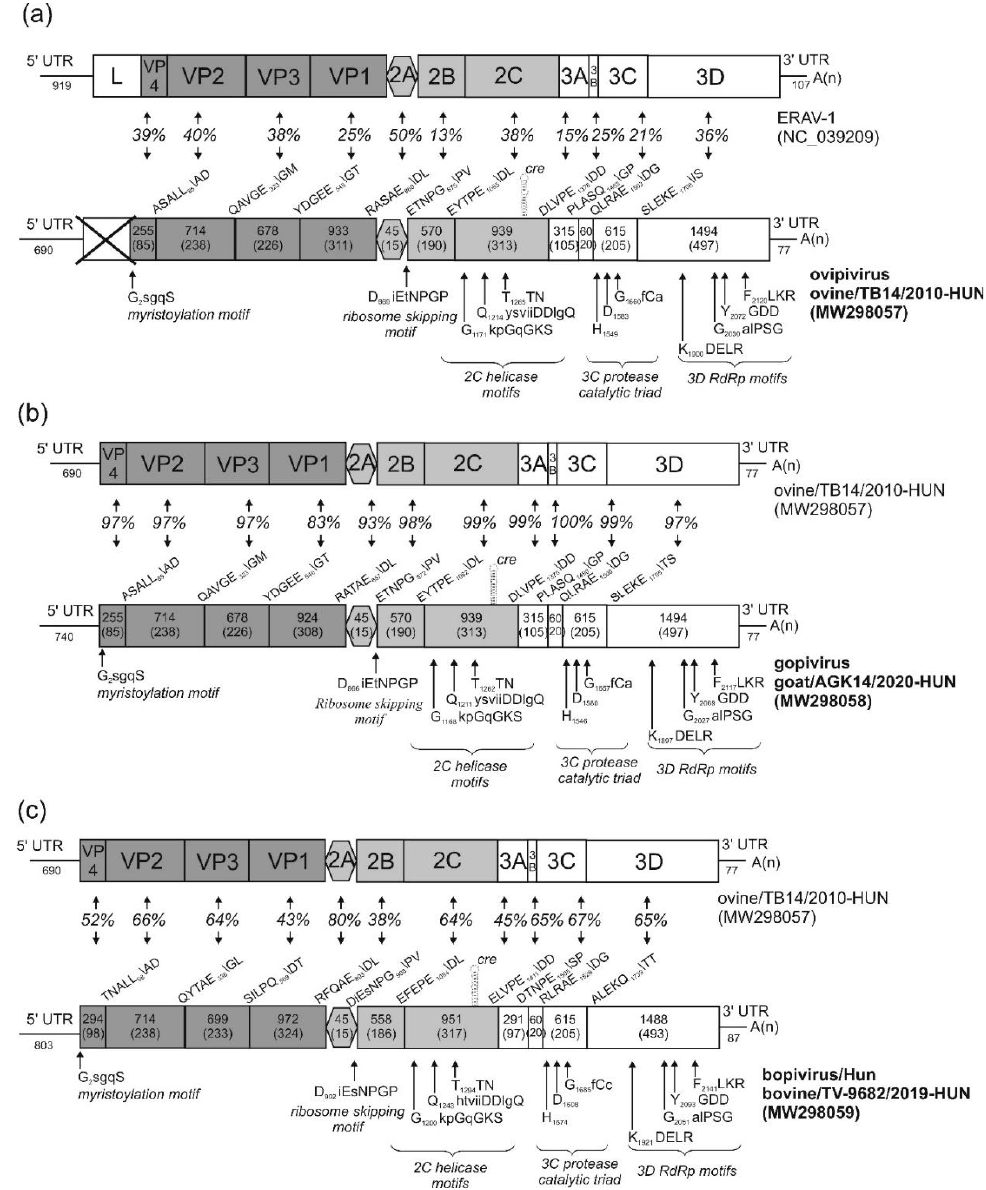
Figure 2. Schematic genome maps with conserved amino acid motifs and presumed cleavage sites (P5\P2 ′ ) of ovipivirus ( a ), gopivirus ( b ) and bopivirus/Hun ( c ) (bottom side of the panels) and their closest relatives (top side). The gene boxes corresponding to the P1 viral capsid proteins and P2 non-structural proteins are highlighted with different shades of grey. The nucleotide (upper numbers) and amino acid (lower numbers in brackets) lengths of the corresponding genomic regions of the study viruses are shown in each gene box. The positions and sequences of conserved amino acid motifs of 2C Helicase, 3C Protease and 3D RdRp (RNA-dependent RNA polymerase) are shown under each map of the study viruses. Conserved and variable amino acids are represented by uppercase and lowercase letters, respectively. The pairwise amino acid identity values (%) of each genomic region are found between the genome maps. cre : cis-acting replication element. The 5 (cid:48) UTR is 690 nt-long, 440 nt longer than bopivirus A1 (KM589358) and shows